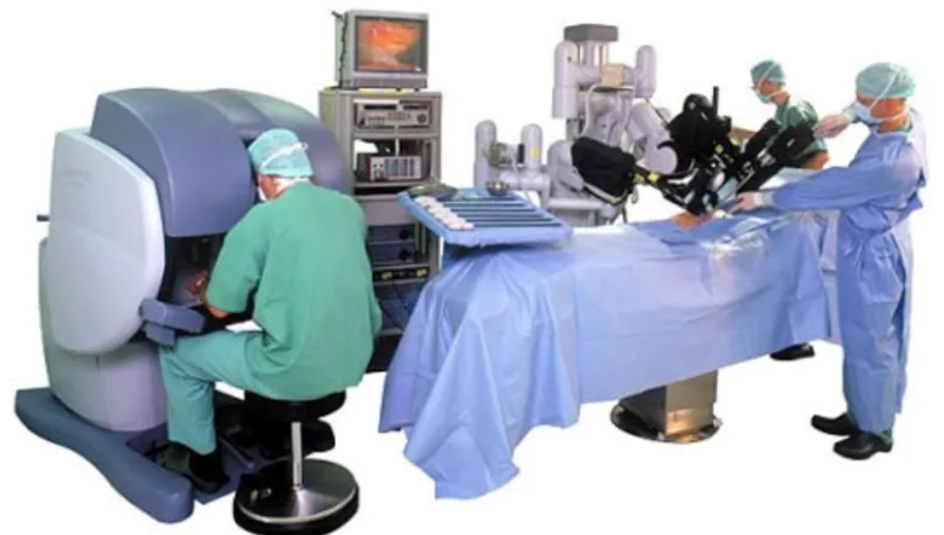
Figure 1. The da Vinci classic teleoperated surgical system, which is still a popular platform for RAMIS research, due to the DVRK extension. Image credit: Intuitive